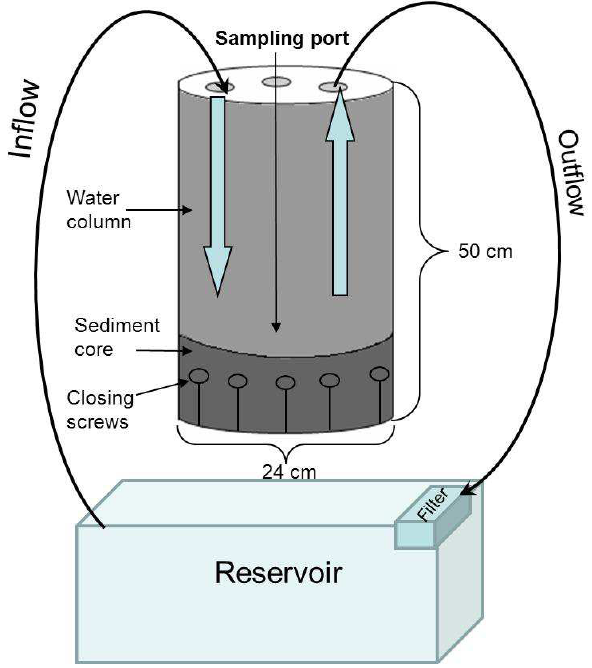
Fig. 2. Schematic of one mesocosm chamber setup. Each reservoir Figure 2. Schematic of one mesocosm chamber setup. Each reservoir was connected to three was connected to three mesocosm mesocosm chambers.